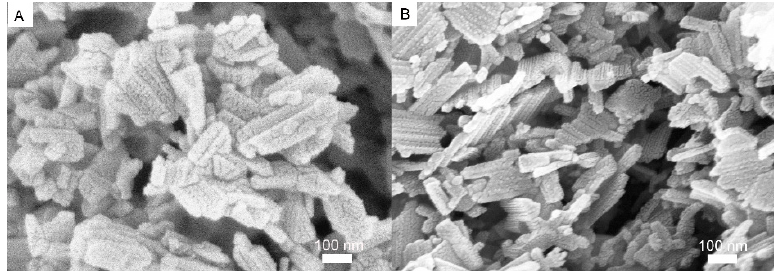
Figure 2. Scanning electron microscopy (SEM) images of undoped LTO ( A ) and Ce-doped LTO ( B ).